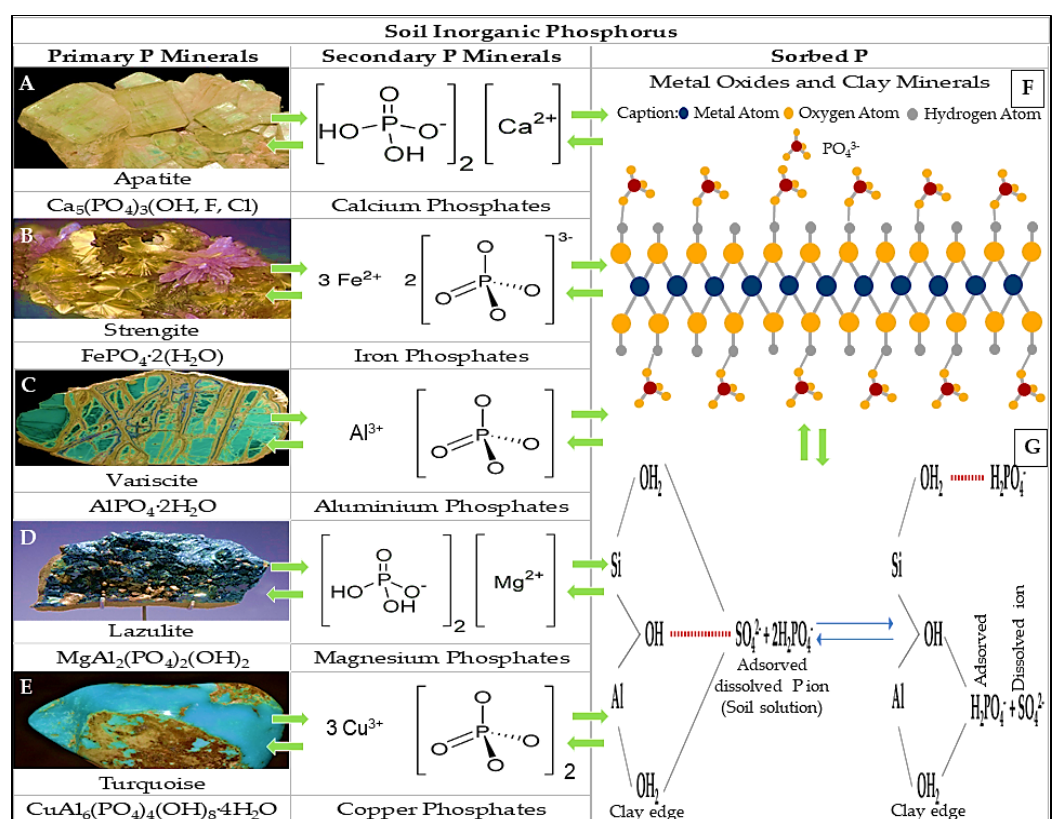
Figure 7. Inorganic phosphorus in soil. ( A ) Apatite (Image author: Parent Géry, Source: Wikimedia Commons, Public domain), ( B ) Strengite, cacoxenite (Image by: Modris Baum, Source: